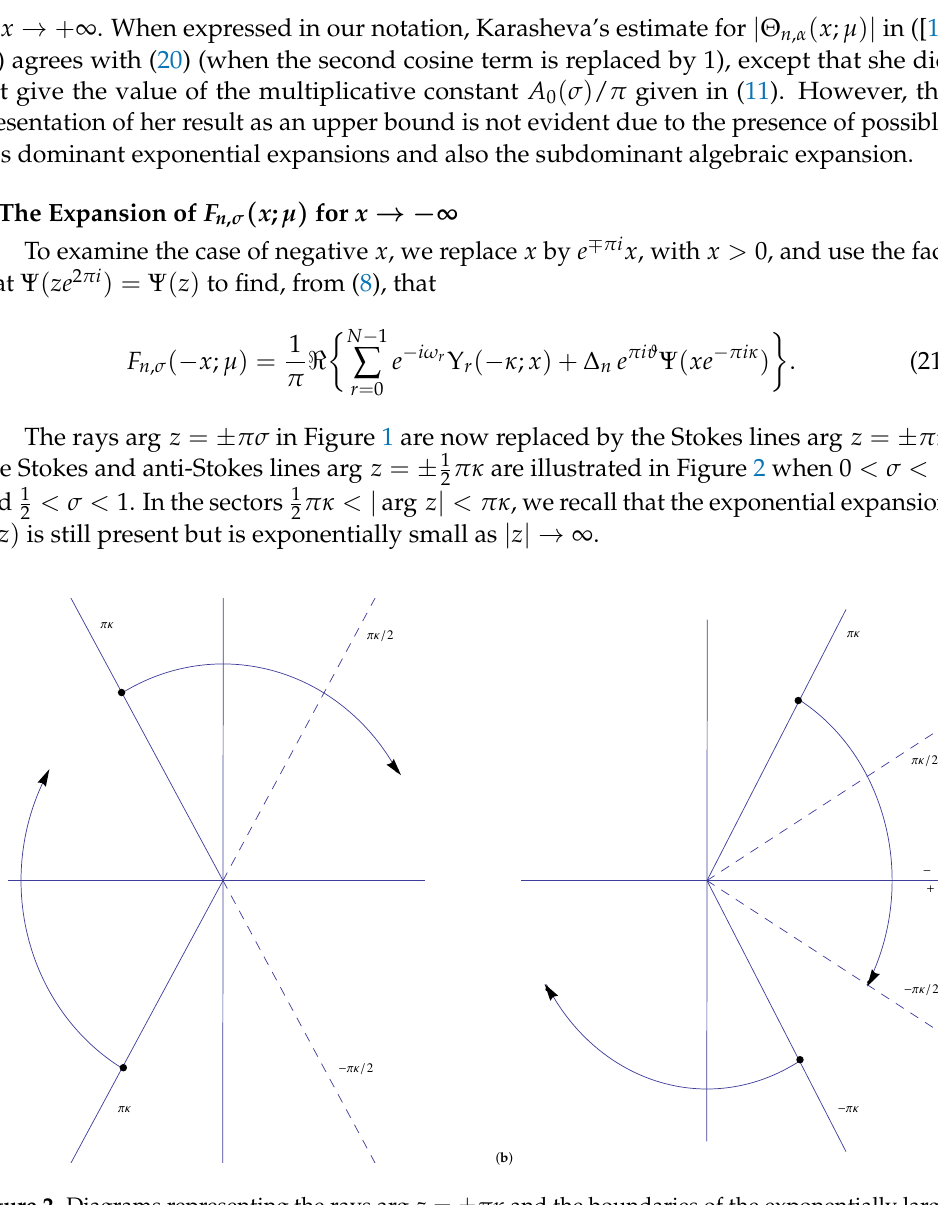
Figure 2. Diagrams representing the rays arg z = sector (shown by dashed rays) circular quadrants represent the range of the arguments arg z = the arrow-head corresponding to n = ∞ . The either side of the Stokes line arg z = 0.